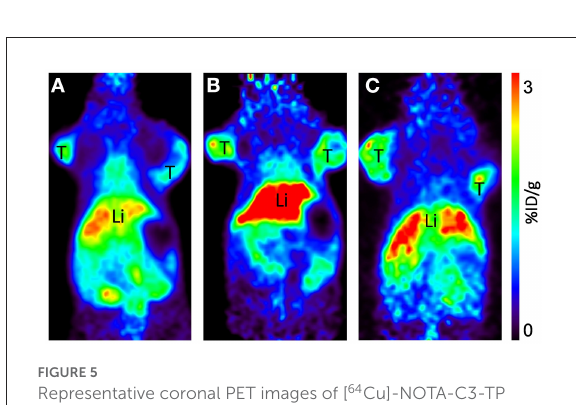
FIGURE5 Representative coronal PET images of [ 64 Cu]-NOTA-C3-TP injected at 30 MBq, at 4 (A) , 24 (B) , and 48h (C) p.i. in HCT116 human colorectal cancer bearing mice. T, tumor; Li, liver. All images are decay-corrected and adjusted to the same maximum value.